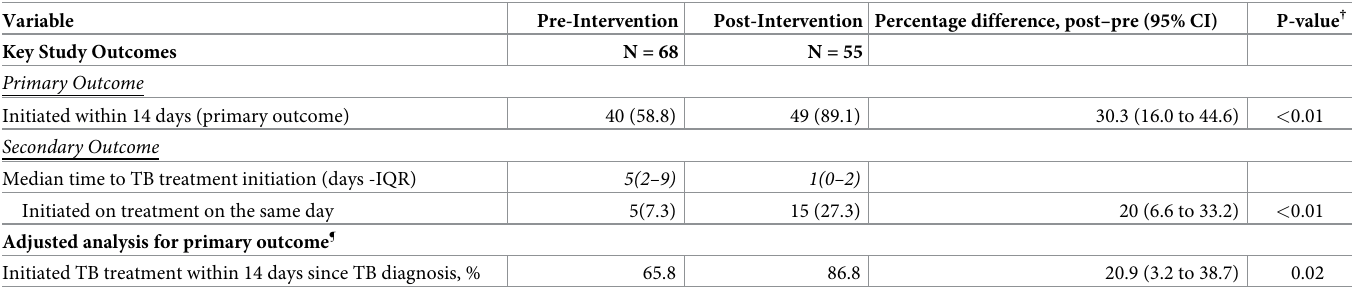
Table 3. Percentage differences in study outcomes pre and post